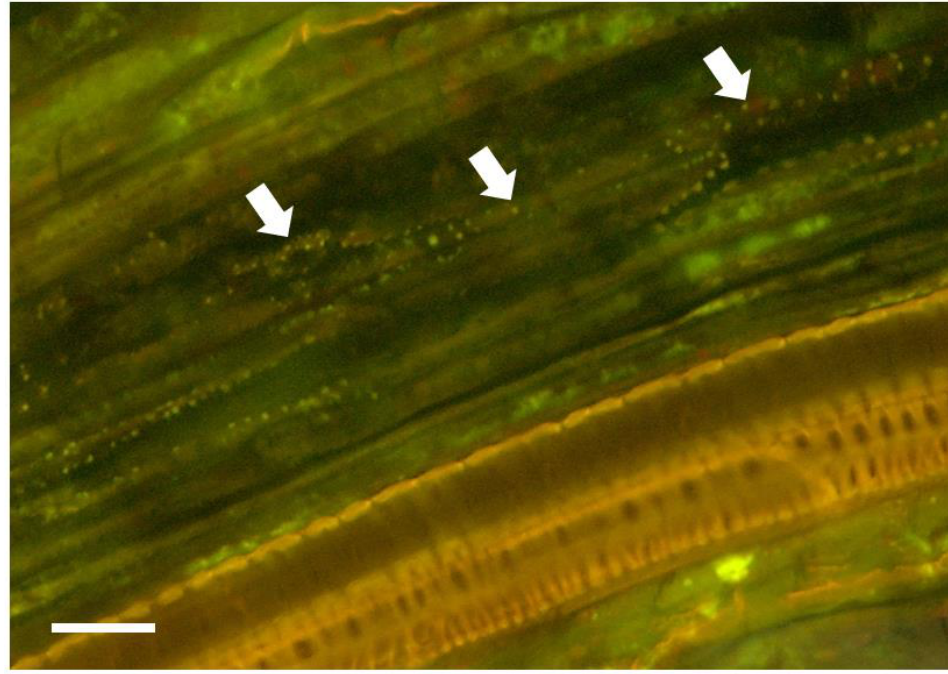
Figure A4. P3AW: mCherry in the vascular bundle in inoculated clover roots. Scale bar = 15 μm.